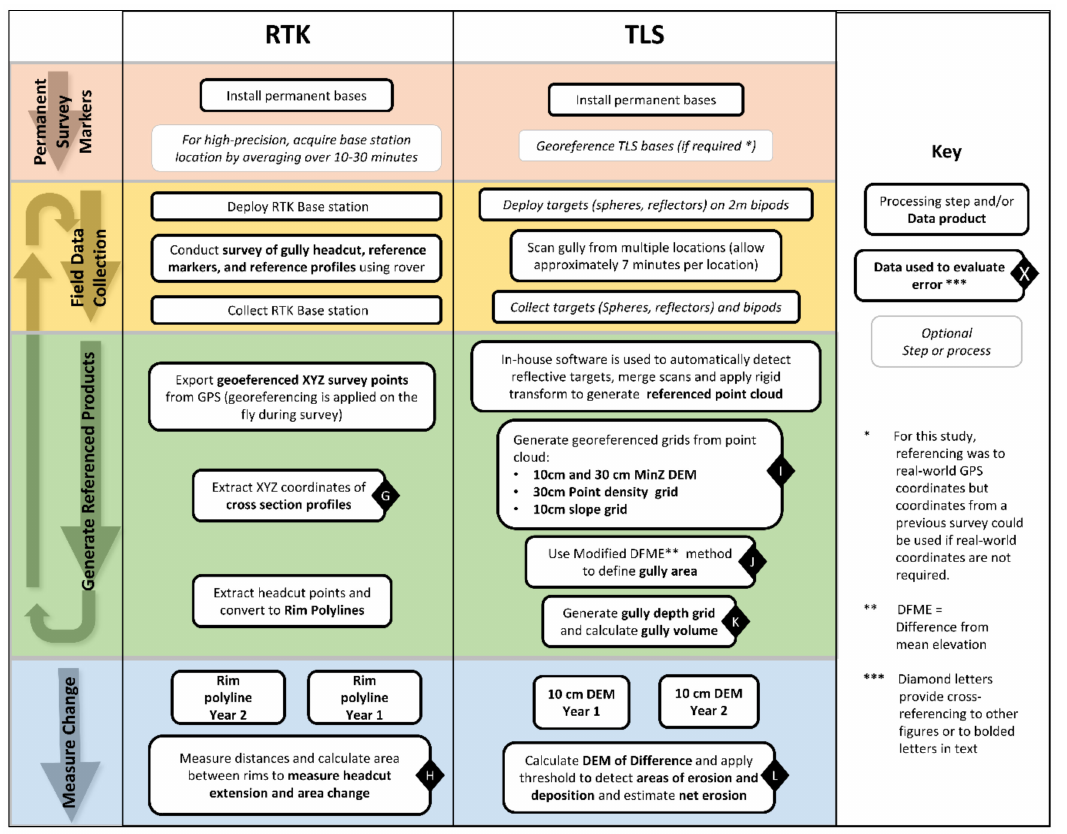
Figure 3. Methodology for preparing validation data. Workflow is similar in structure to the HLS workflow in Figure 2. Black diamonds show datasets which were used in error evaluation. Black diamond letters are cross referenced in the text using bolded